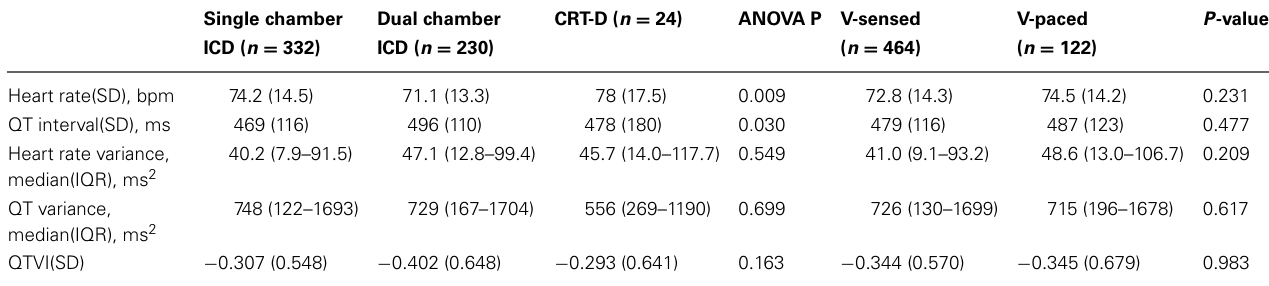
Table 2 | Comparison of all-visits averaged ECG parameters in patients with single-, dual-chamber ICD, and CRT-D, and in patients with sinus ventricular-sensed and ventricular-paced